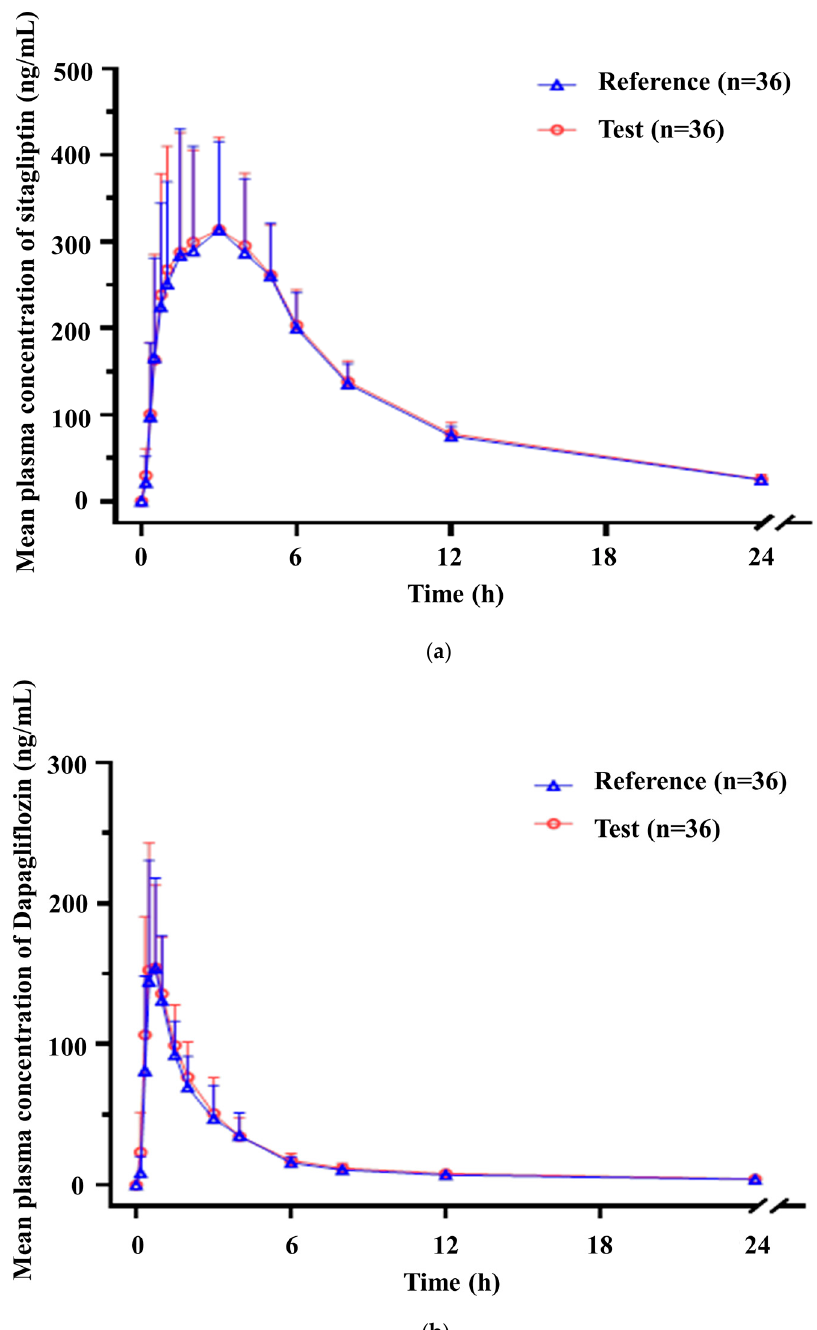
Figure 11. Mean plasma concentration of ( a ) sitagliptin and ( b ) dapagliflozin from 0 h to 24 h after administration ( n = 36).